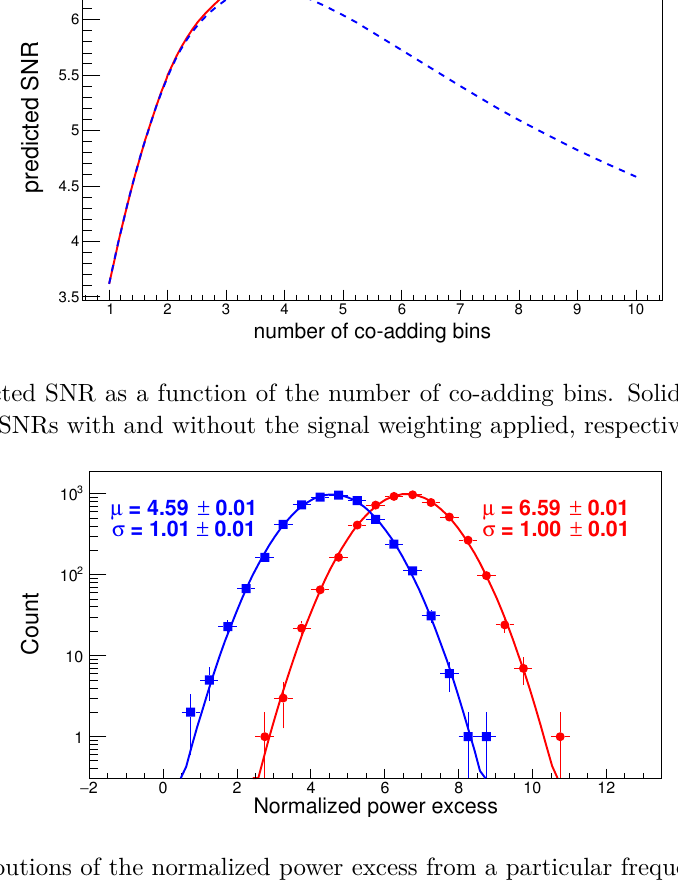
Figure 3 . Distributions of the normalized power excess from a particular frequency bin where we put simulated axion signals, with (circles) and without (rectangles) the signal weighting applied. Lines are a Gaussian